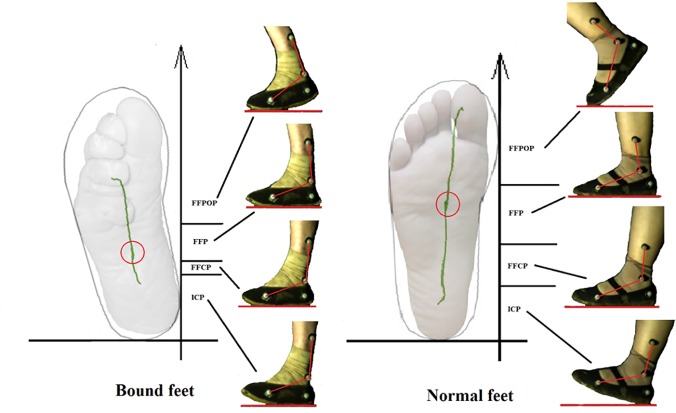
The center of pressure (CoP) trajectory of bound feet (left) and normal feet (right) (ICP represents Initial Contact Phase, FFCP represents Forefoot Contact Phase, FFP represents Flat Foot Phase and FFPOP represents Forefoot Push Off Phase; the circle indicates the location of CoP while stance phase.)